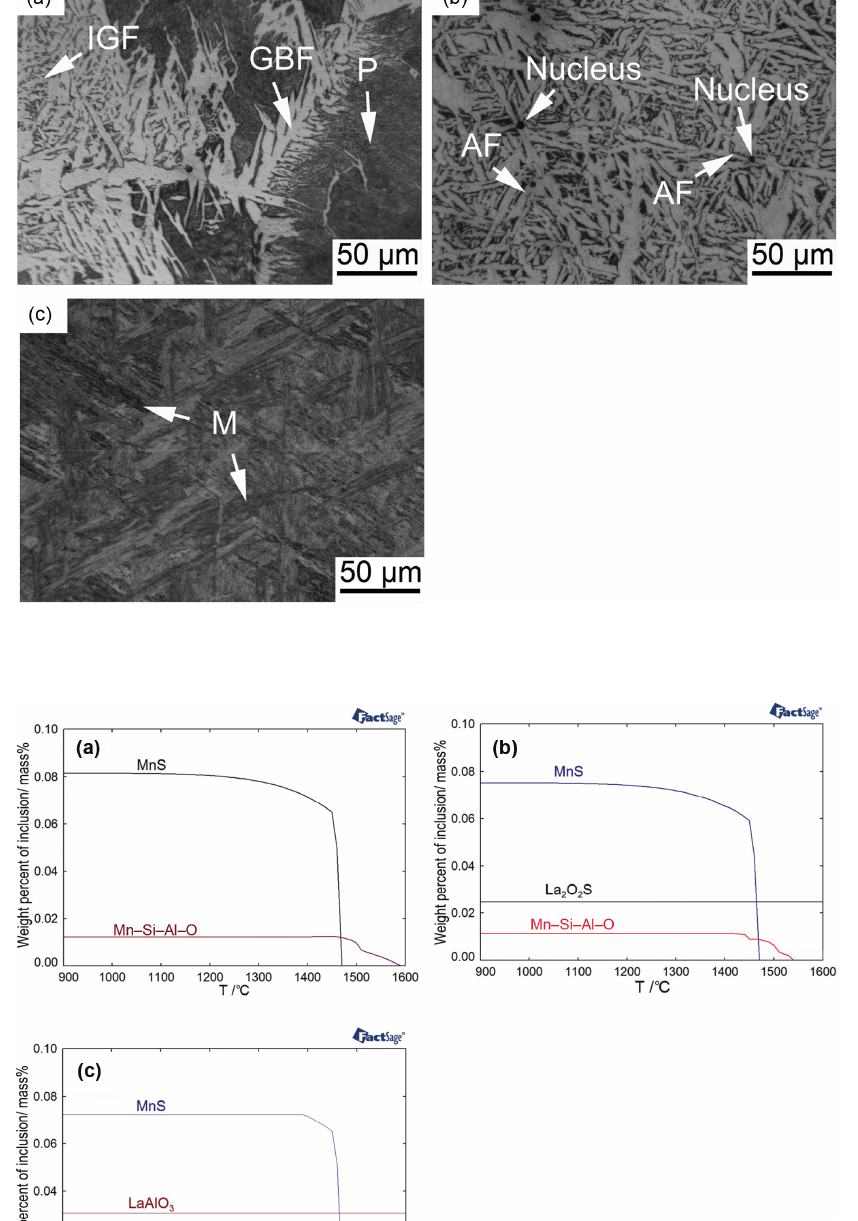
Figure 3: Calculated equilibrium weight percent of inclusions in steels (a) AR1, (b) AR2 and (c)